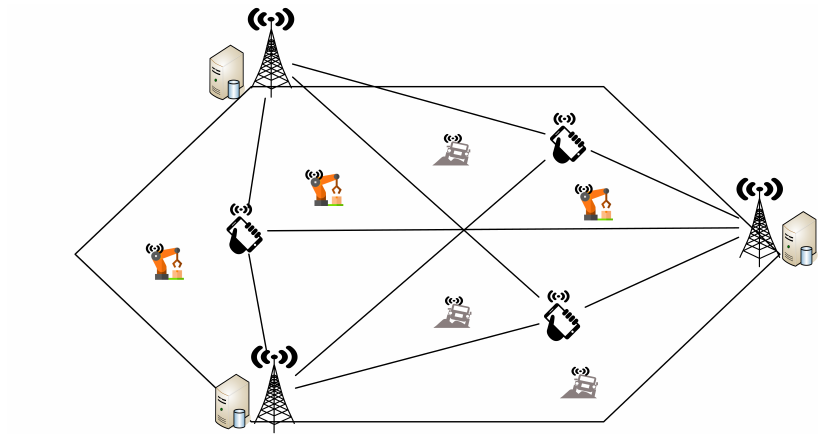
Figure 1. K -User MIMO X network Example for K =